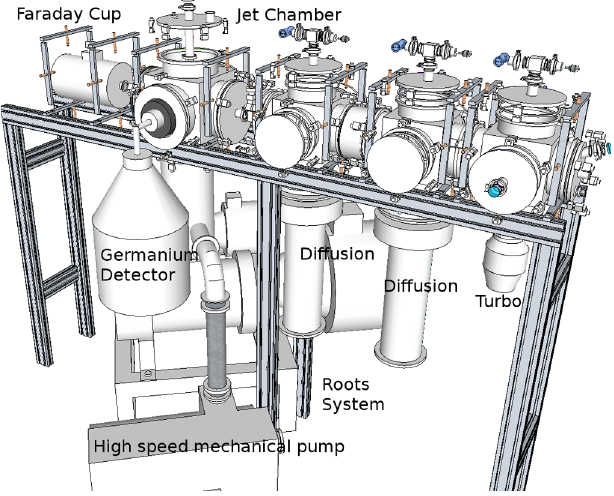
FIG. 1. 3D sketch of SUGAR. The differential pumping system is on the right-hand side towards the accelerator beam line. The scattering chamber (with a HPGe detector) is on the left. The beam line ends in a Faraday cup at the far left.